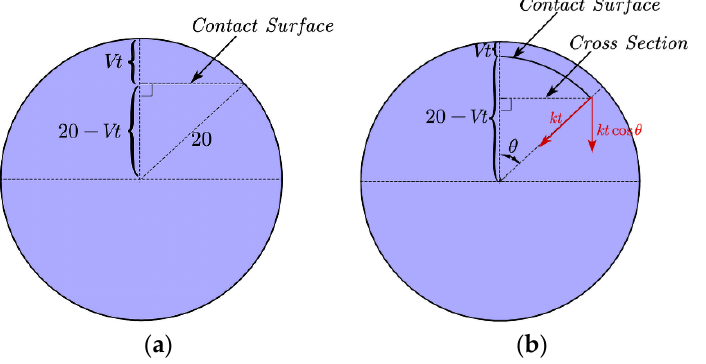
Figure 8. ( a )The diagram of the upper contact surface. ( b ) The diagram of the lower contact sur-